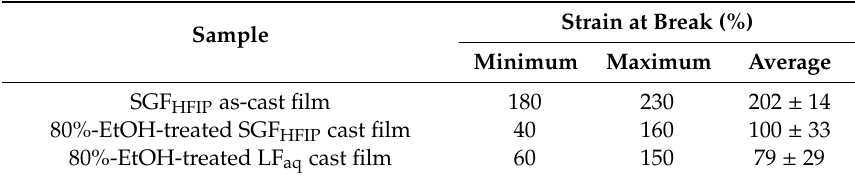
Table 2. Strain at break (mean ± SD; %) of the as-cast SGF HFIP and 80%-EtOH-treated SGF HFIP and LF aq films (n = 19).